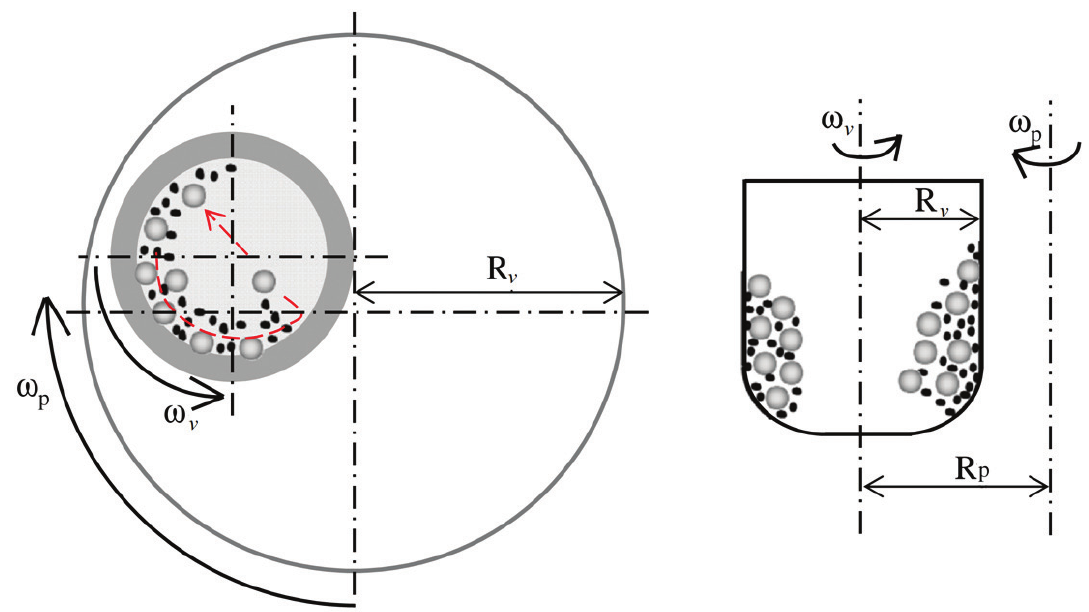
Figure 1. The schematic diagram of the planetary ball mill and the